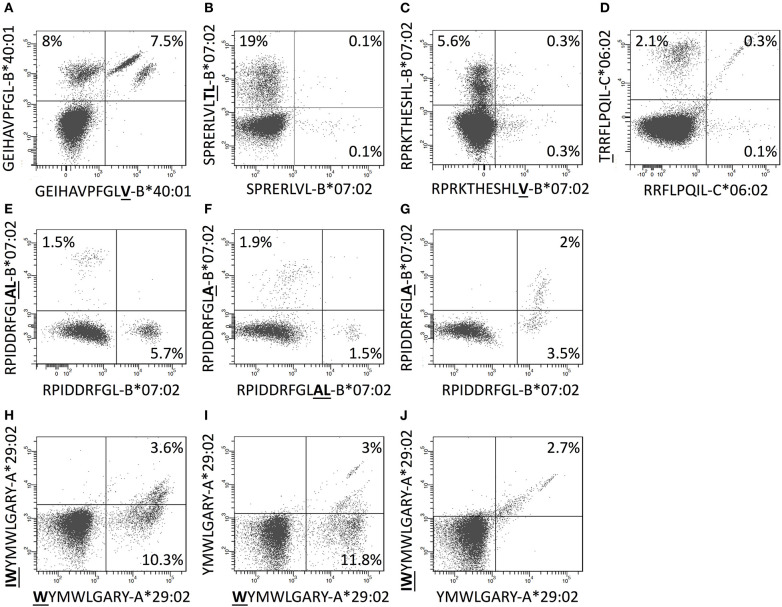
CD8+ T cells double stained with combinations of tetramers of size-variants epitopes. (A–J) PBMCs were in vitro expanded for 8 days with relevant 15-mers peptides, and subsequently stained with pairs of tetramers representing size-variants epitopes as indicated in the figure (one member of each pair was PE-labeled and the other was APC-labeled) and analyzed by flow cytometry gating for CD3+CD8+T cells.